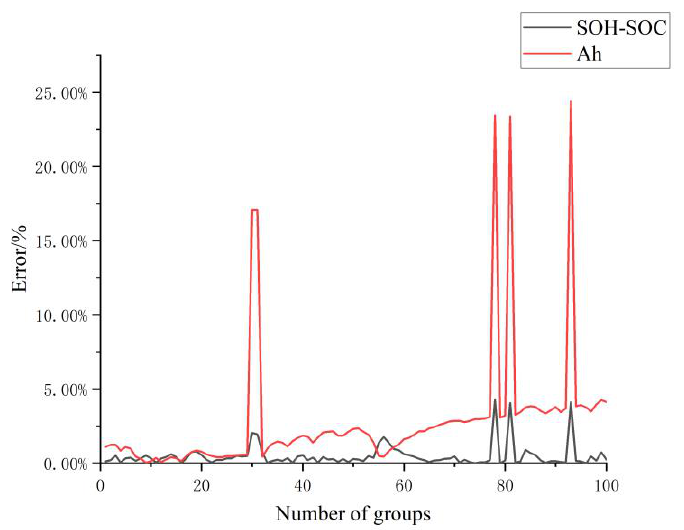
Figure 15. CALCE battery data error curve.